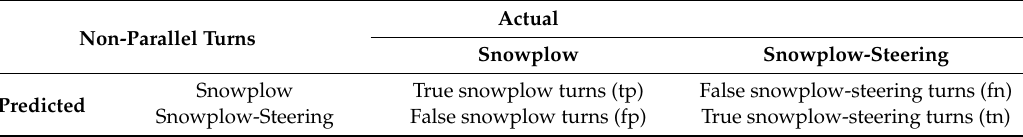
Table 2. Confusion matrix for non-parallel turns.